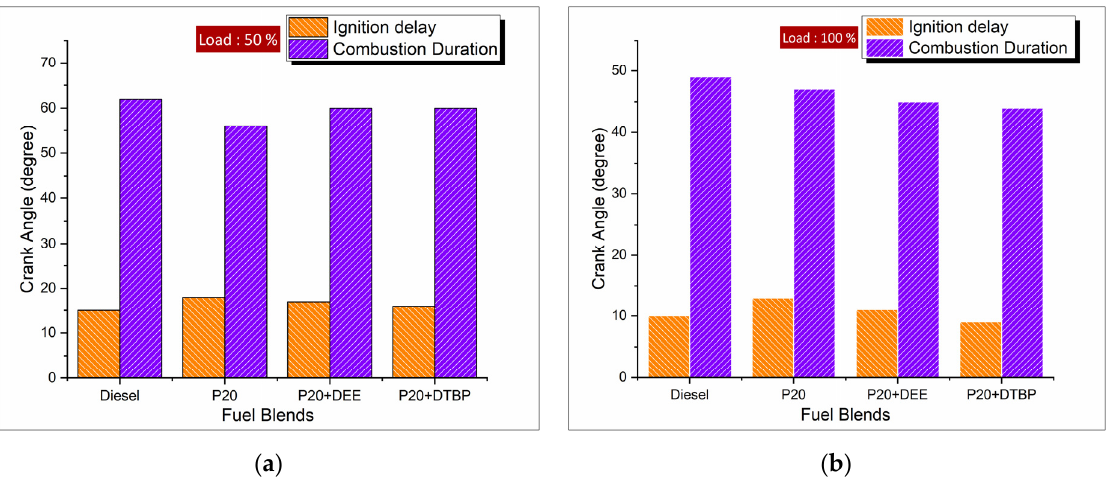
Figure 4. Ignition delay and combustion duration variation for test fuel blends, ( a ) at 50% load; ( b ) at 100% load.